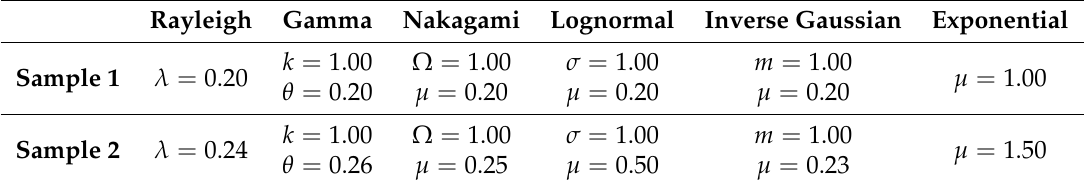
Table 1. Distributional parameters for case (i) and (ii). λ , k , θ , Ω , m , u , and σ represent the scale, shape, scale, spread, shape parameters, log mean, and log standard deviation, respectively.